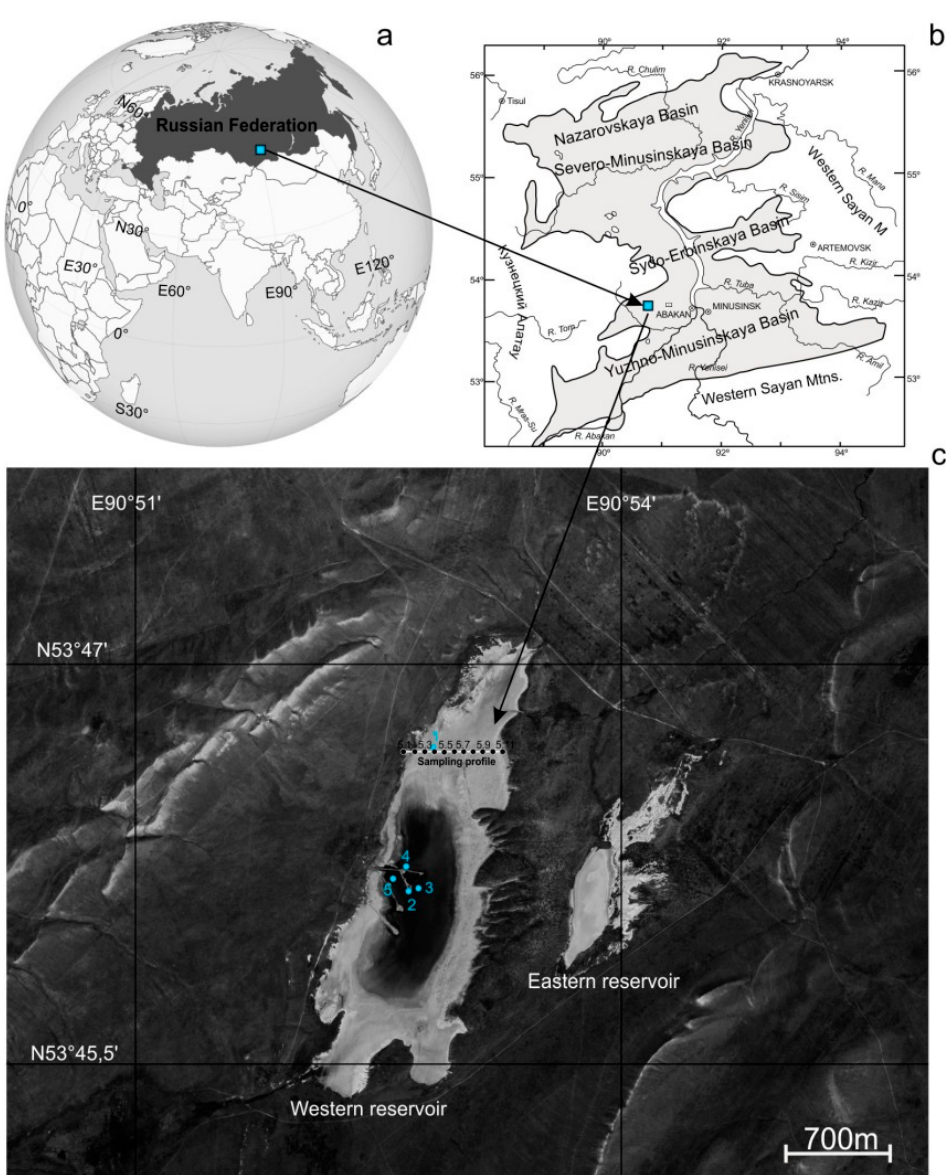
Figure 1. Quick map of the location of Lake Taloe with a map of the actual material ( c ). The figure shows the geographic location of Lake Taloe ( a , b ). Note: points 5.1–5.11 (black) are lake sediments sampled from a profile 50 m apart. Points 1–5 (blue)—water samples.